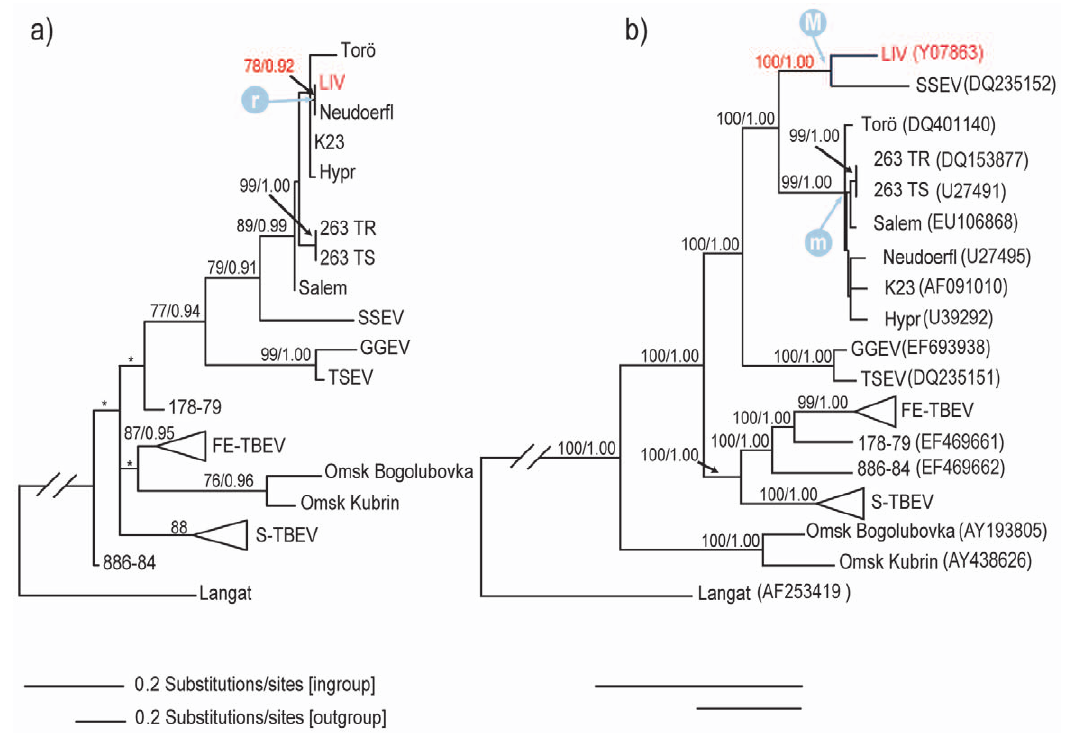
Figure 3. Most likely phylogram from the maximum likelihood analysis of the partitioned NS3-gene. The partitions of NS3 correspond to (a) the recombinant fragment nt 1320–1524, (b) nt 1–1319 concatenated with nt 1525–1866. Numbers above nodes indicate branch support (bootstrap support $ 70%/Bayesian posterior probability $ 0.90). Asterisks (*) mark nodes that that are not recovered by Bayesian inference. Bars show different amounts of substitution for the in-group and out-group taxa. The position and branch support of LIV are indicated in red. ‘‘M’’ and ‘‘m’’ refers to the divergences of the major parent and minor parents respectively, while ‘‘r’’ points to the recombination event in the tree. Genbank accessions are indicated in parentheses.